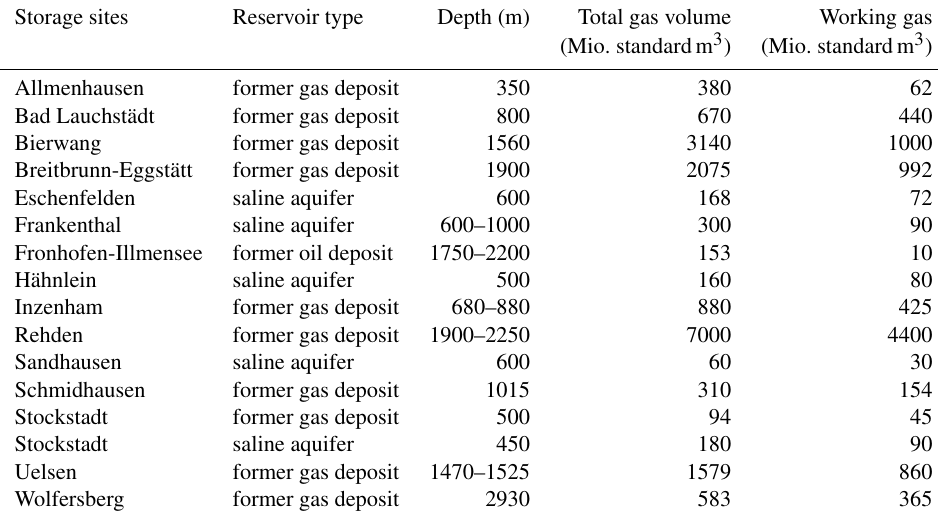
Table 1. Natural gas storage in operation in porous reservoirs in Germany (EID, 2019). Storage